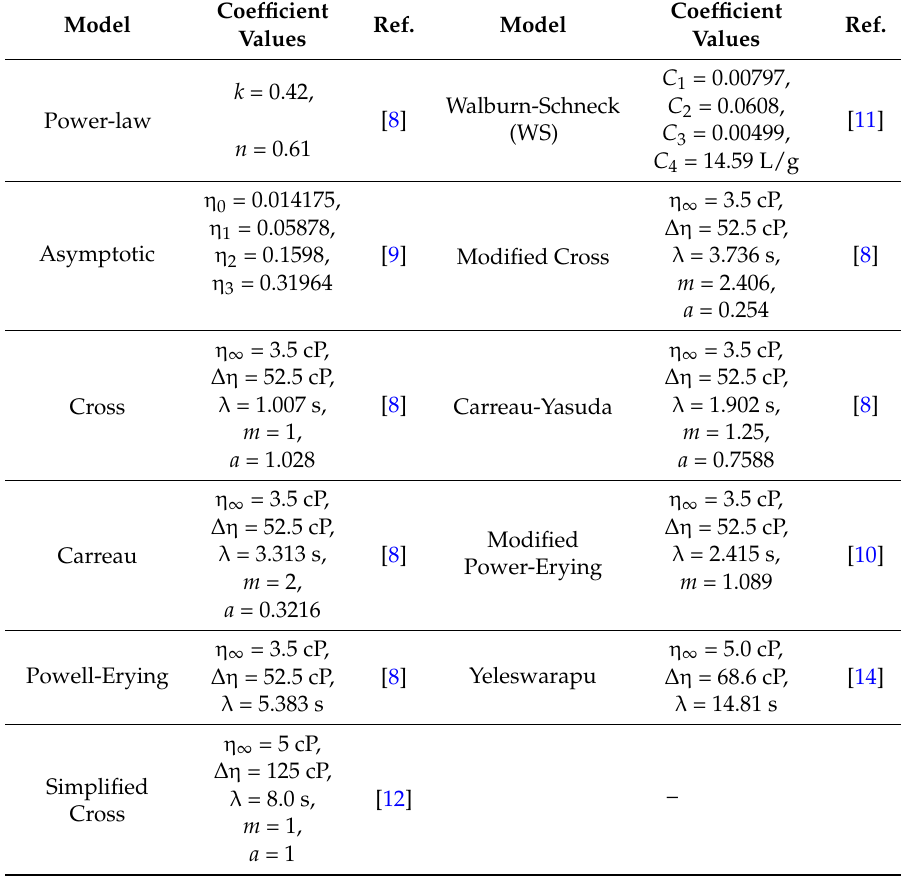
Table 2. Coefficients for blood viscosity models presented in Table